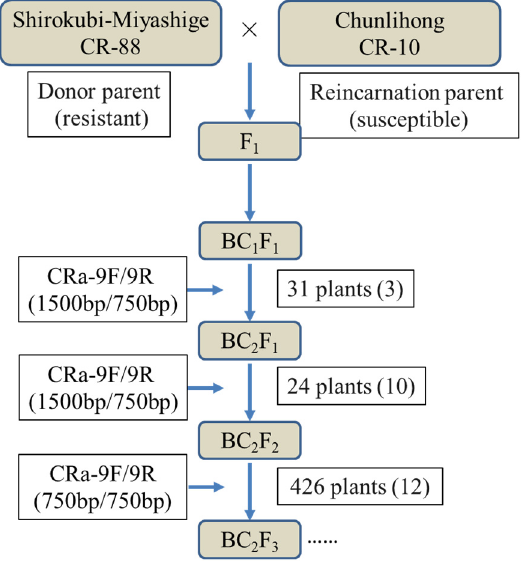
Figure 5. Schematic diagram of backcrossing combined with molecular marker-assisted selection of a CR gene. The value in parentheses is the number of selected individuals with CRa-9F/9R resistant genotypes.